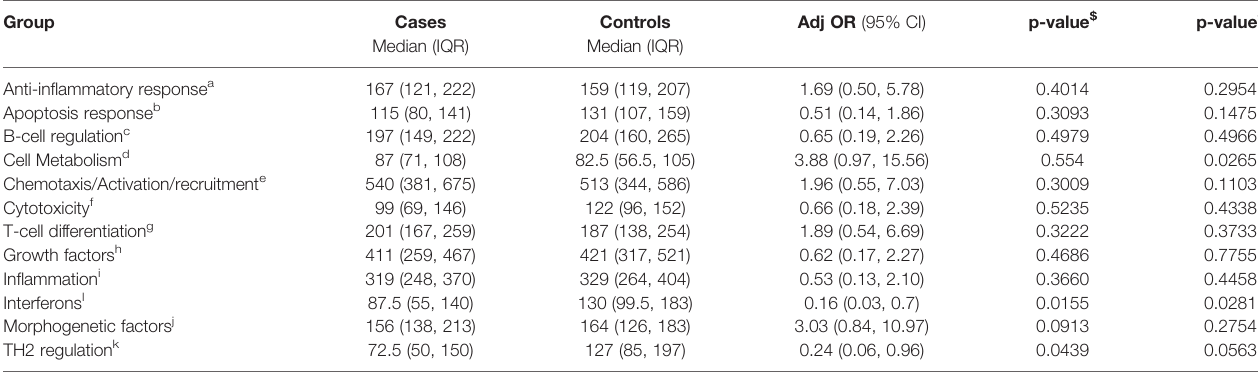
TABLE 3 | Adjusted O ’ brien method analysis by groupings. Group Cases